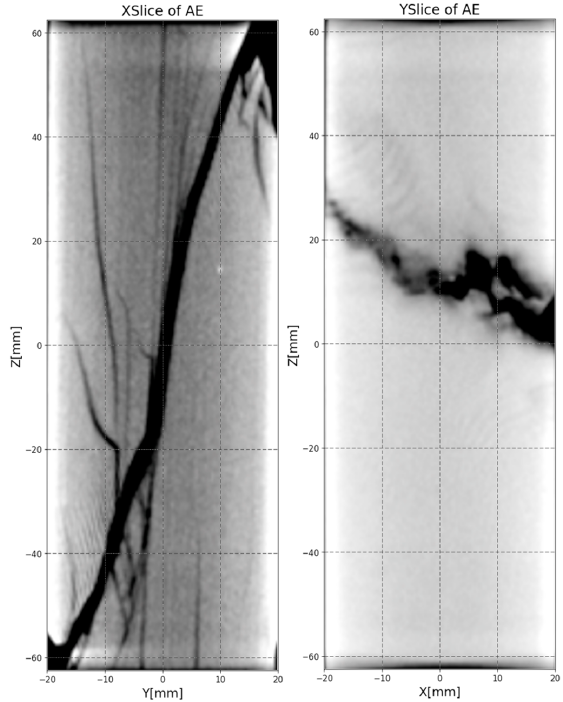
Figure 10. The axle CT scan images in the X and Y direction after hydraulic fracturing.